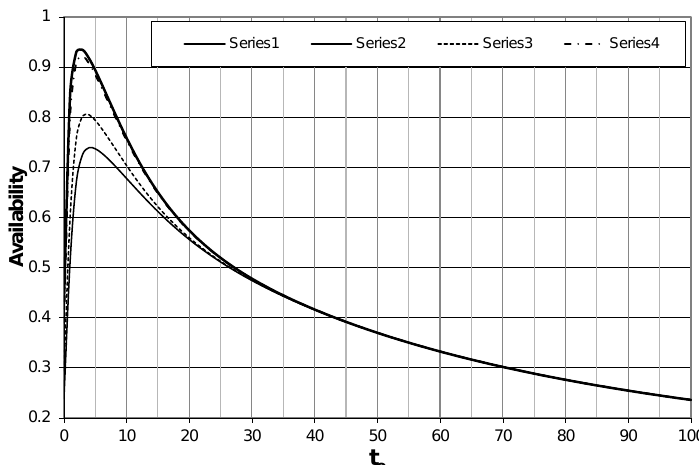
Fig. 3: The availability the system based on different parameter values